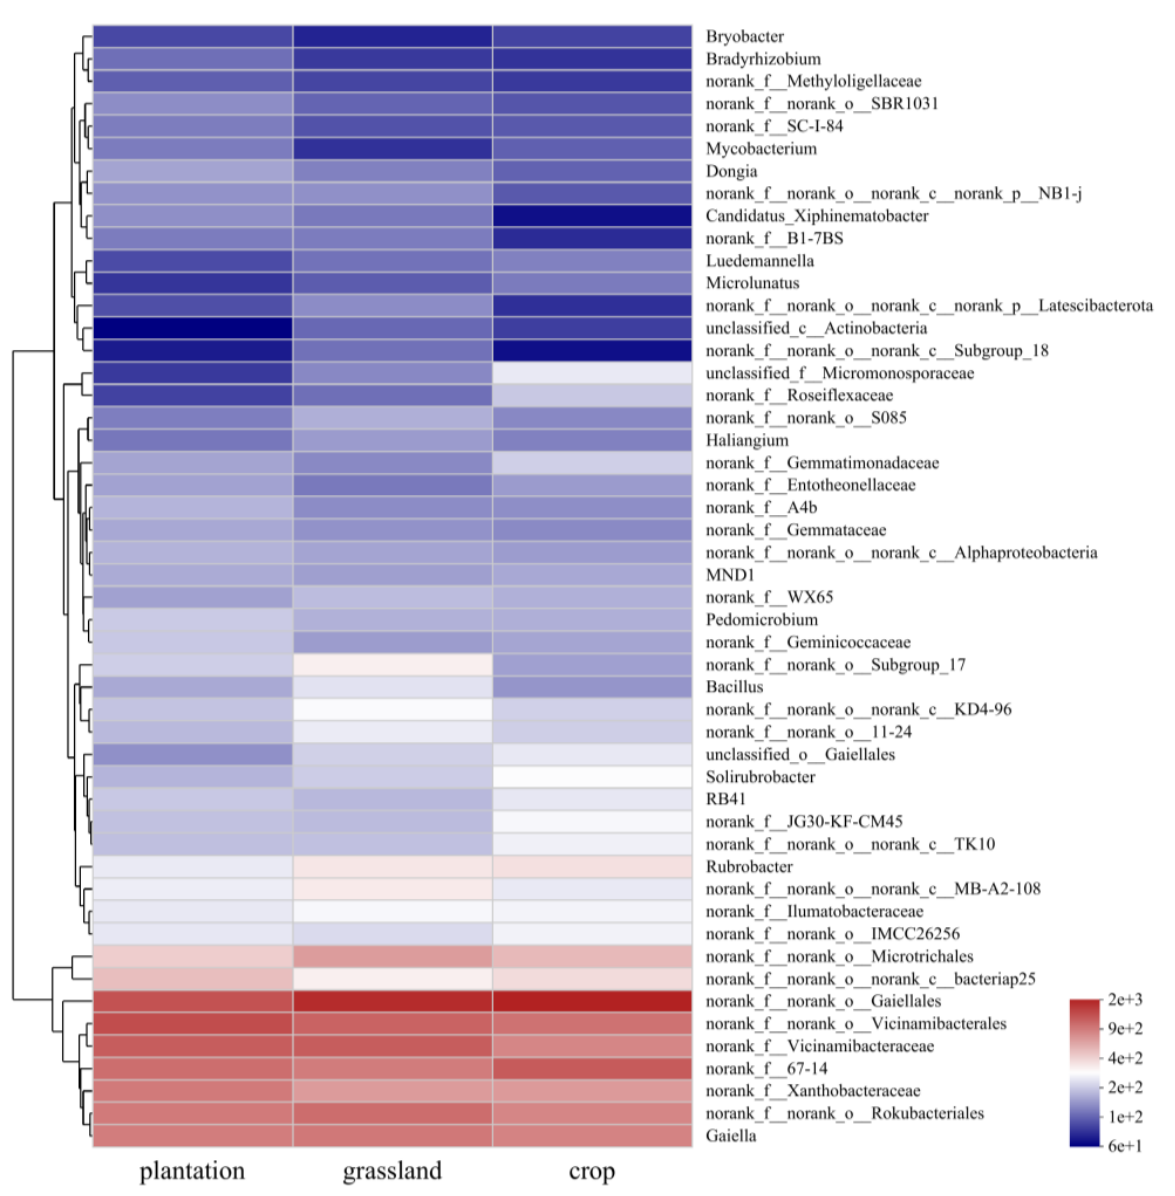
Figure 6. Heat maps and hierarchical clustering of the top 50 genera of soil bacterial community abundance in three karst land-use types.